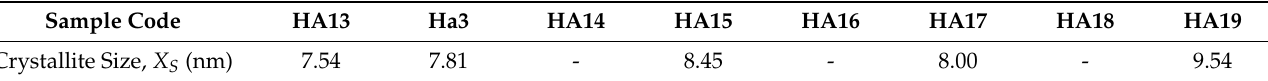
Table 4. Crystallite size calculated from the XRD patterns for the 002 line of HA.